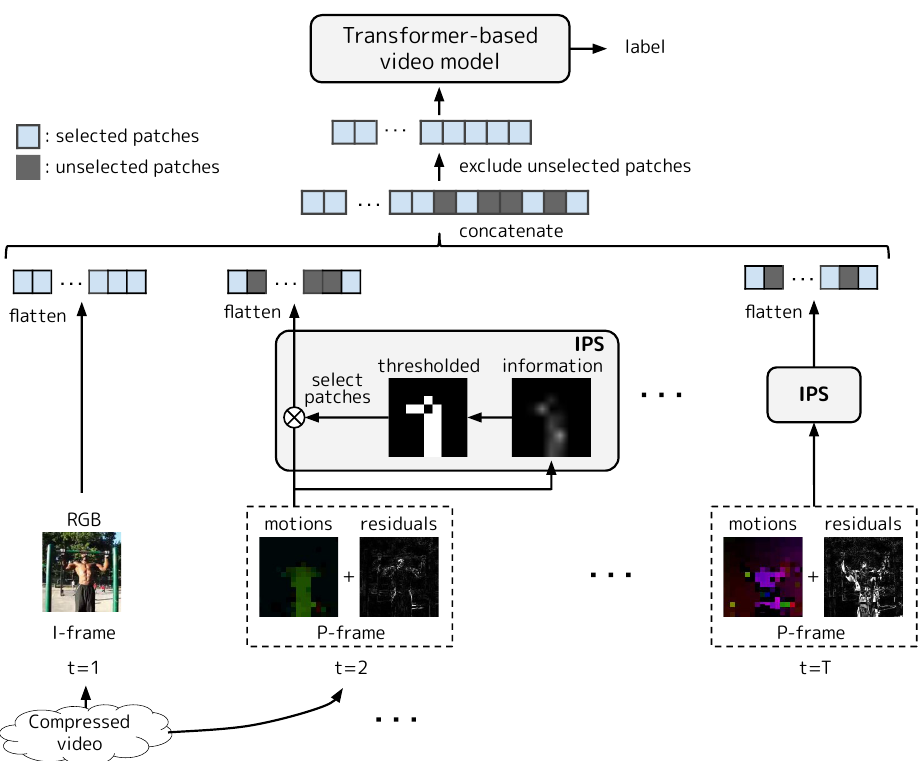
Figure 1. Overview of Transformer-based compressed video modeling with IPS. First, I-frames and P-frames in a compressed video are decoded into RGB values and motions+residuals, respectively. Second, both the I-frames and the P-frames are divided into patches. Then, while all the patches are inputted into a Transformer-based video model for the I-frames, for P-frames, only patches selected based on their information content by IPS (see Section 3.4 for details) are inputted. Finally, the Transformer-based model outputs some label (e.g., action class) associated with the input